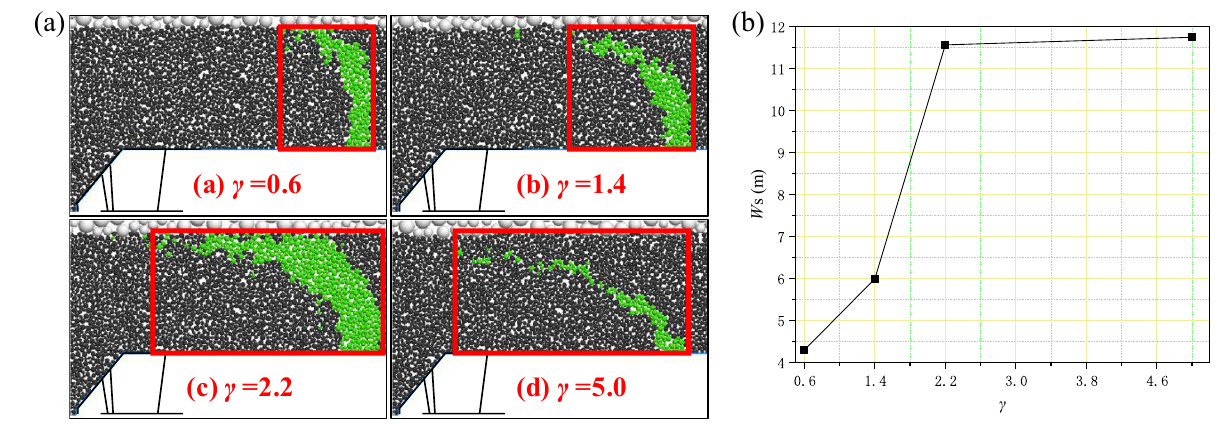
Fig. 23 a Shape of DB13 (green particles) for different γ in normal cycling; b Variation of W